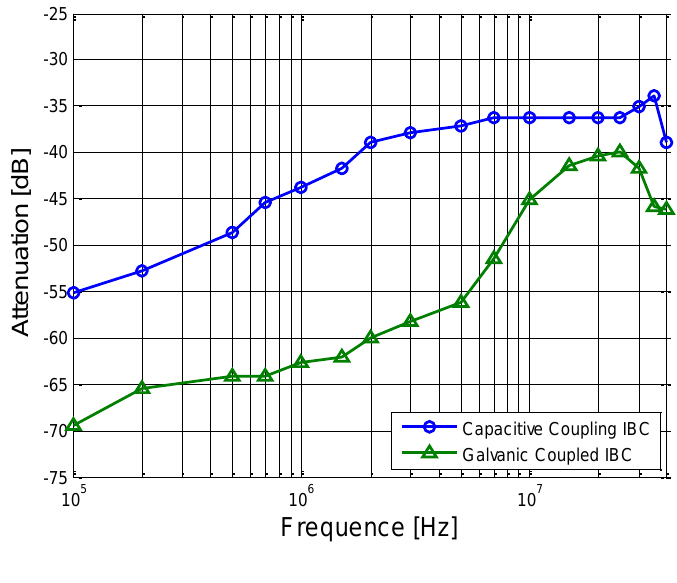
Figure 8. Measurement results of the proposed method and the implant IBC based on galvanic